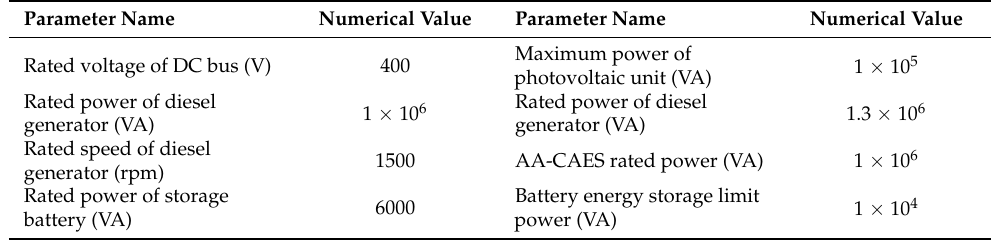
Table 4. Main parameters of the